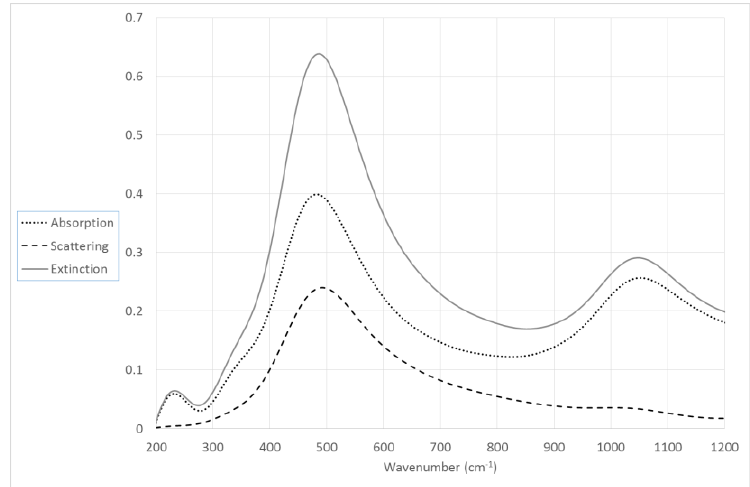
Figure 3. Spectral response for rectangular prism shaped n-type doped germanium (n-Ge) particle (material 2 in Table 2) calculated using FDTD. Height 1 μm, length 2 μm, width 1 μm.